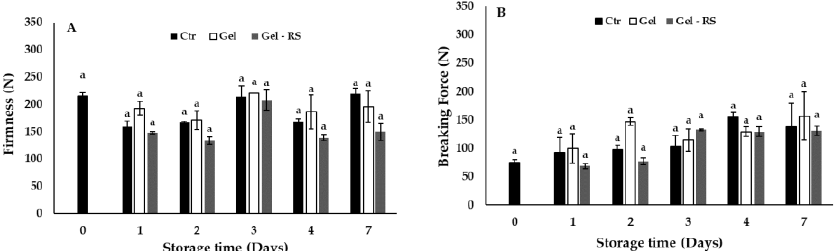
Figure 2. Firmness (N) ( A ) and Breaking Force (N) ( B ) of coated fresh cut zucchini samples during a 7-day storage period. Lack columns indicate Ctr treatment; white columns indicate Gel treatment and grey columns indicate Gel-RS treatment. Different letters indicate statistical differences. Different letters within the columns indicate significant differences ( p < 0.05) among the different treatments on every sampling date. Sample analysis was in triplicate.